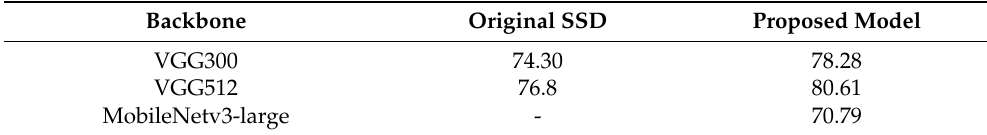
Table 2. The experimental result (mAP %) comparison of the proposed model and the original SSD model on the Pascal VOC dataset. VGG300 is the VGG16 backbone with an image size of 300 × 300, and VGG512 is for an image size of 512 ×